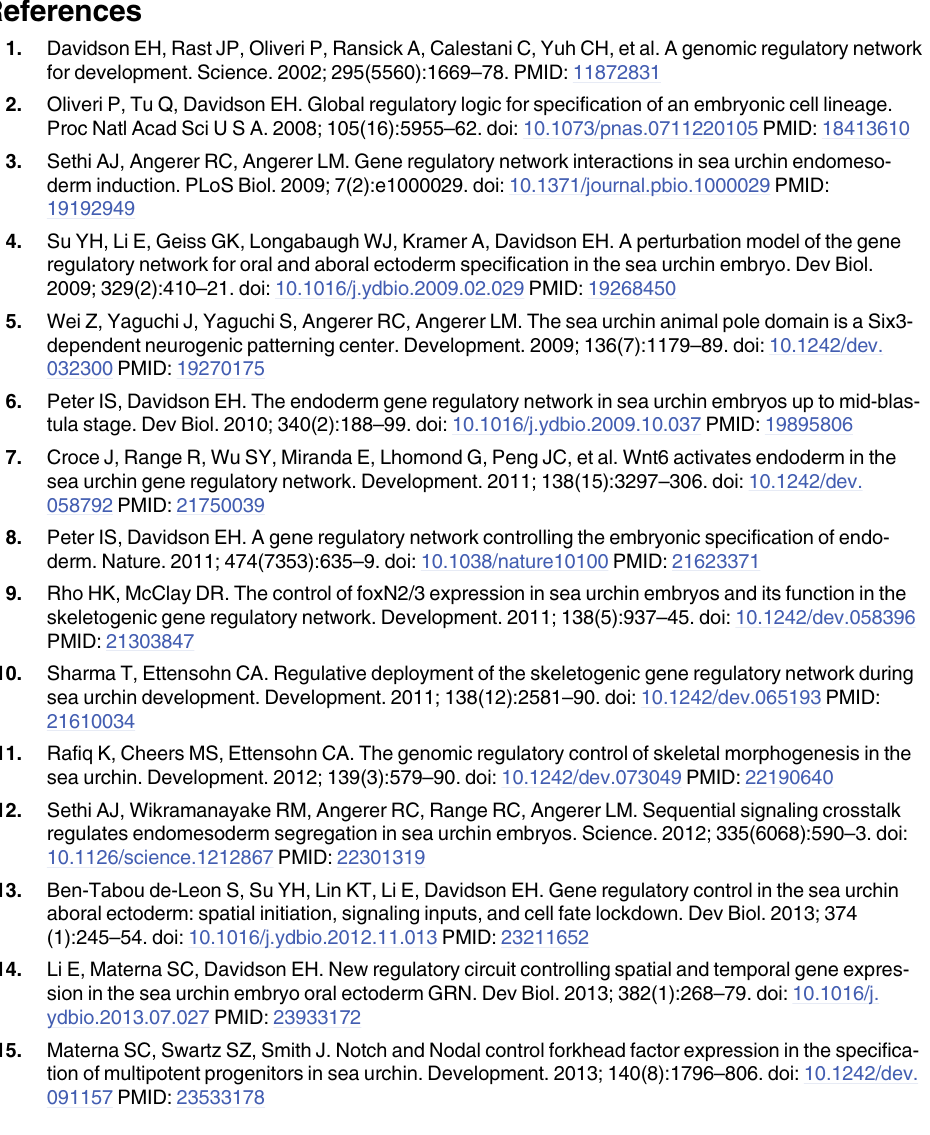
S7 Table. Categorical enrichment results for c = 5 and c = 9.